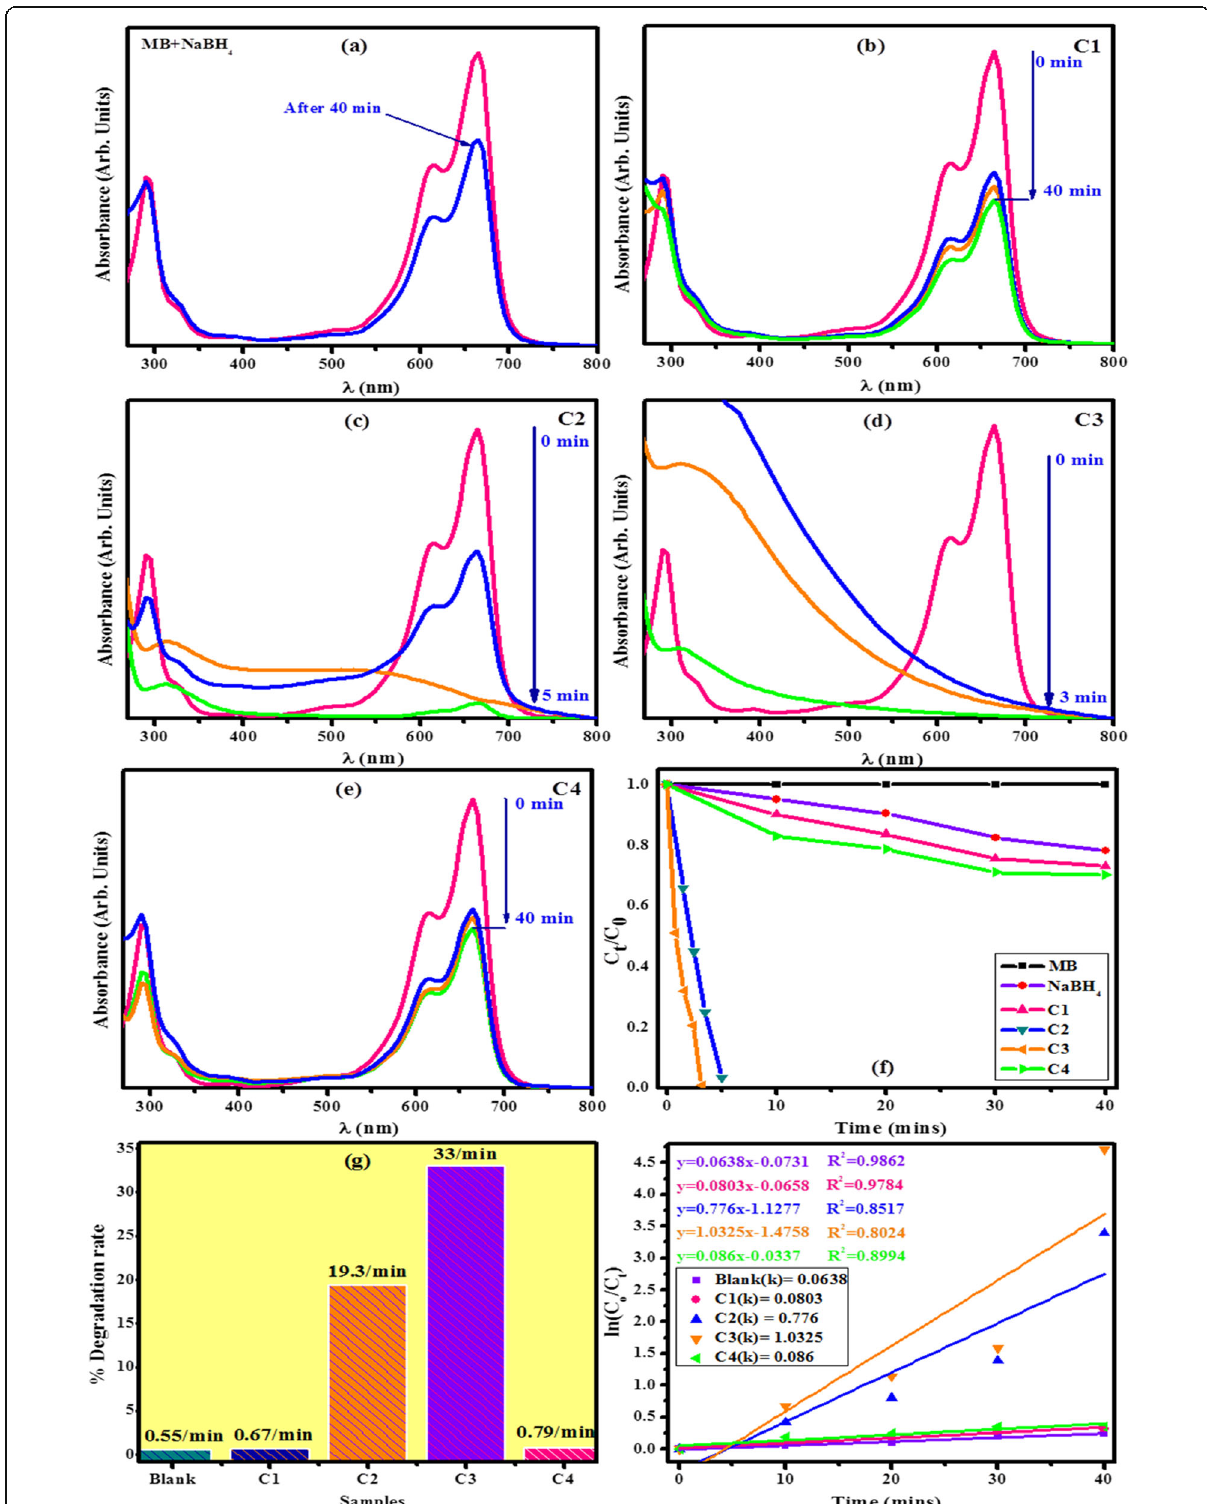
Fig. 8 Time dependent UV – Vis spectra for the reduction of MB. a MB with NaBH 4 . b MB with NaBH 4 + C1. c MB with NaBH 4 + C2. d MB with NaBH 4 + C3. e MB with NaBH 4 +